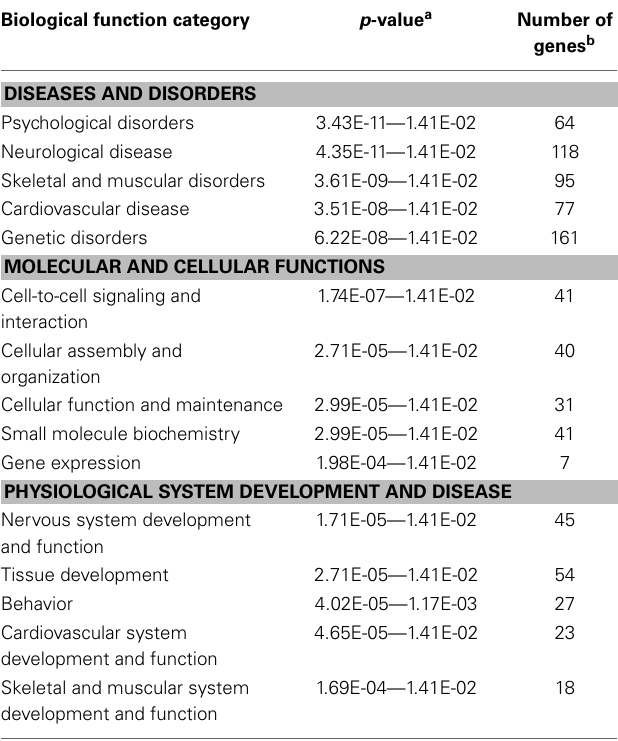
Table 2 | Gene ontology of altered genes at 120hpf in the 5 Gy